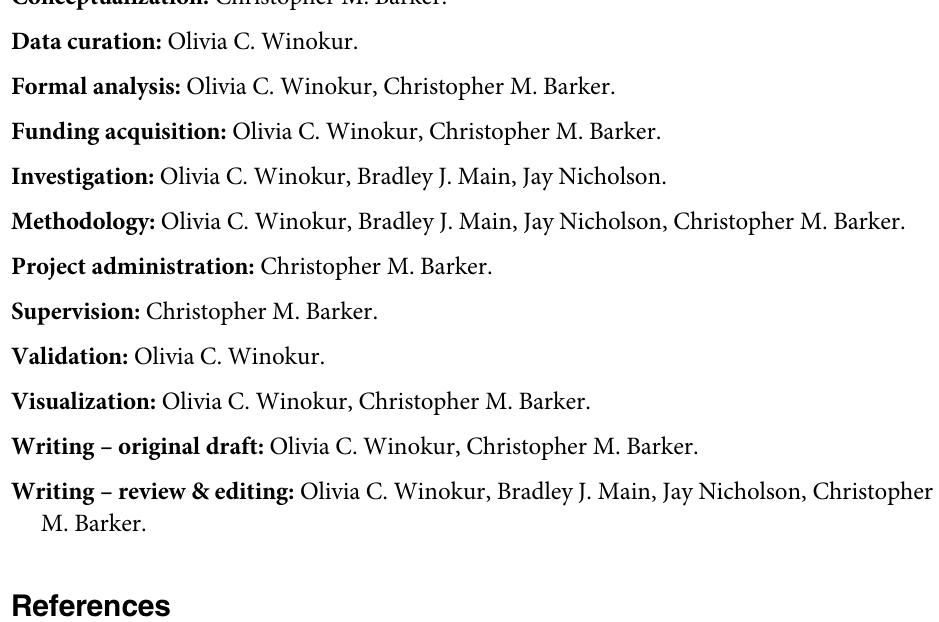
S2 Table. Coefficients from the linear model for the probability of ZIKV transmission as a function of dissemination titer. Due to no significant difference in the logistic curves for 26 and 30˚C, data were pooled and dissemination titer was binned to the nearest 0.5 log